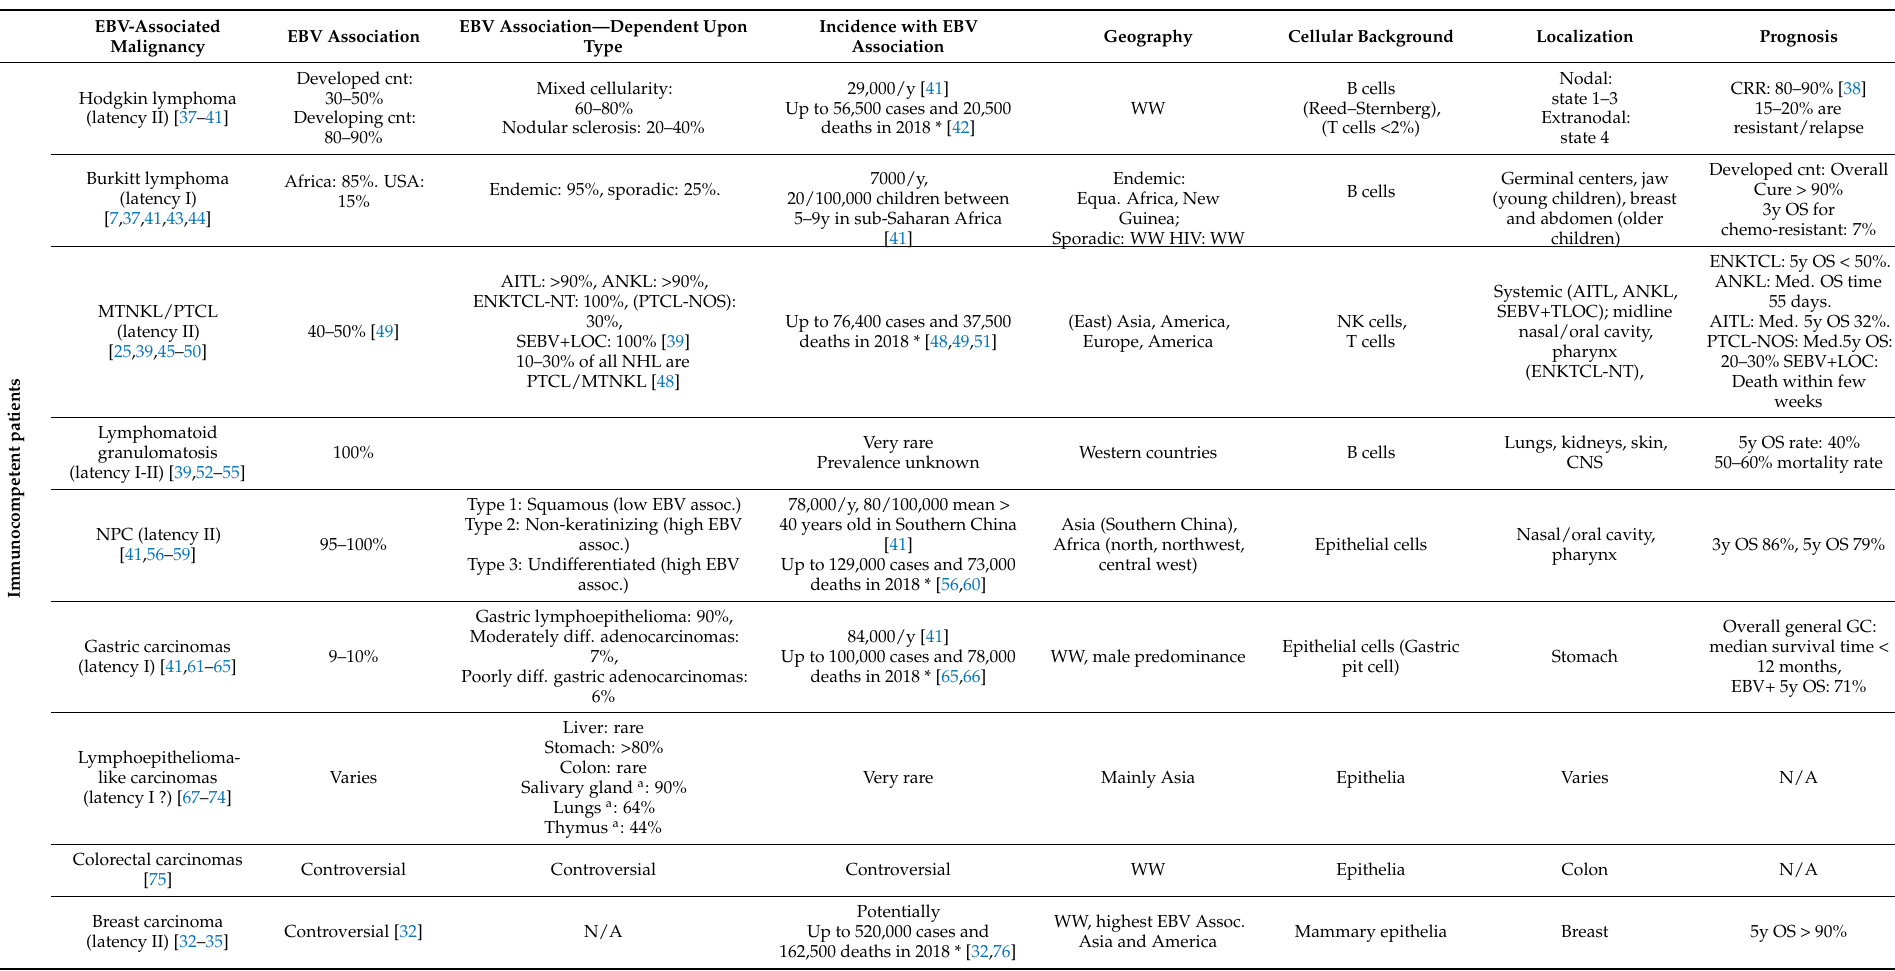
Table 1. Description of malignancies in terms of their respective latency program, their EBV-association, the EBV-association depending on the type of the respective disease, the global incidence with EBV-association, the geographical distribution of the disease, the cellular background of the disease, the localization of the disease in the body and the prognosis through the overall survival rate (OS), the progression free survival (PFS), the objective response rate (ORR) and complete remission rate (CRR) where applicable. Inspired by